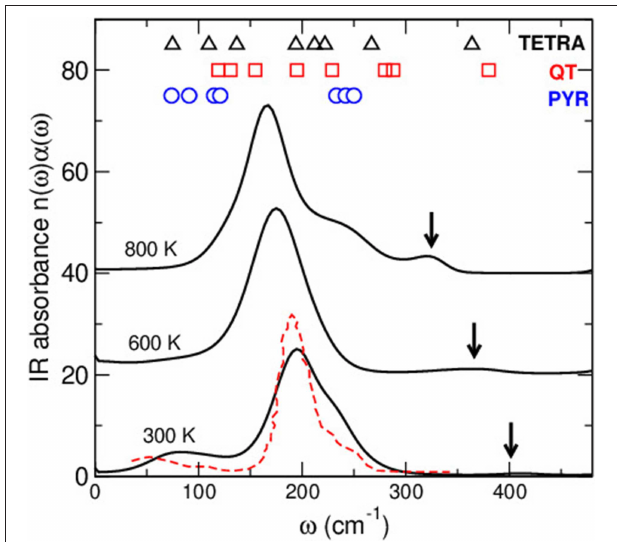
FIGURE 4 | Calculated IR absorbance spectra in amorphous and liquid As 2 Se 3 , compared to the measured spectra for As 2 Se 3 ( Lucovsky et al., 1975) (broken red curve). On top are reminded the location of the typical vibrational modes of a pyramidal unit AsSe 3 / 2 (PYR), the quasi-tetrahedral unit Se=AsSe 3 / 2 (QT) unit and a tetrahedral As (see numbers in Table 1